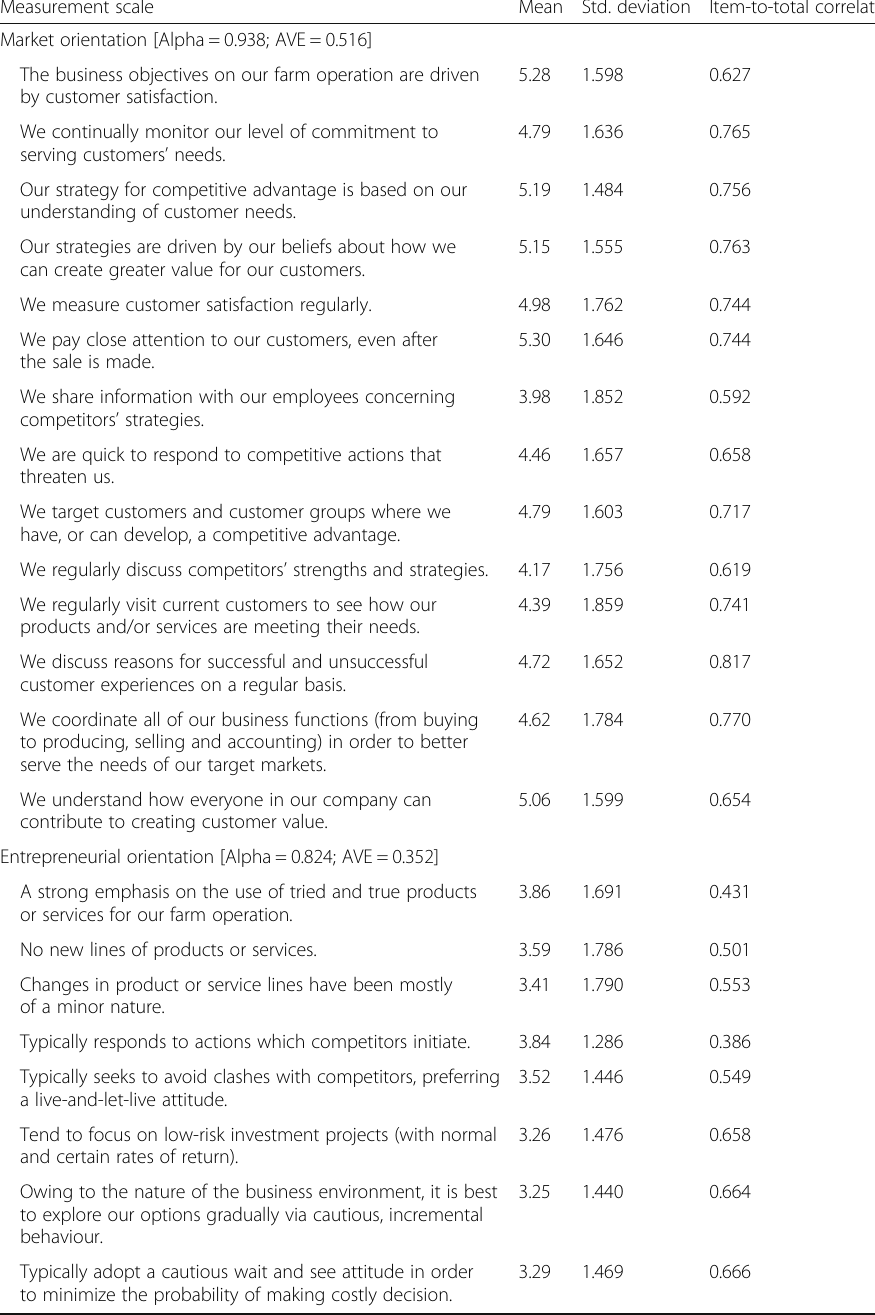
Table 8 Items of managerial orientation scales and scale reliabilities Measurement